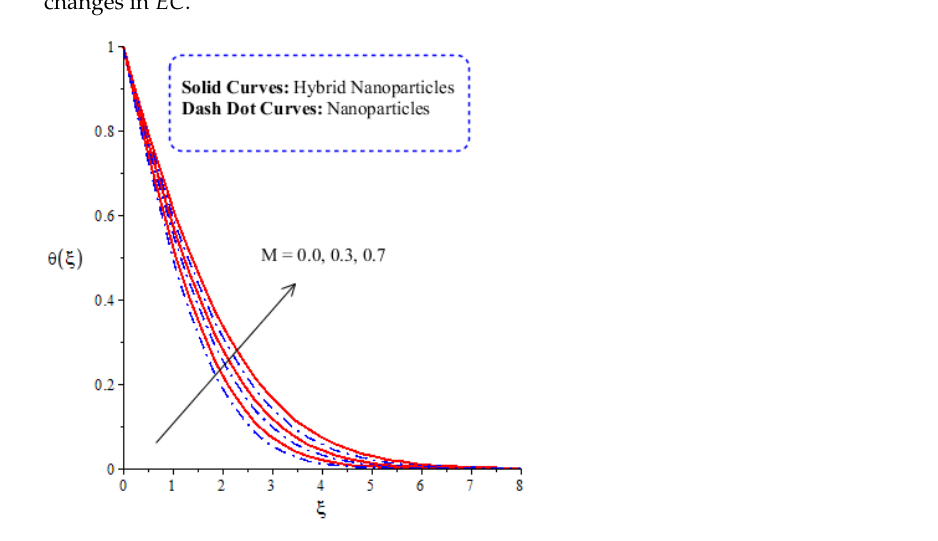
Figure 13. Comparative analysis of thermal energy in hybrid nanoparticles and nanoparticles with changes in 𝑀.